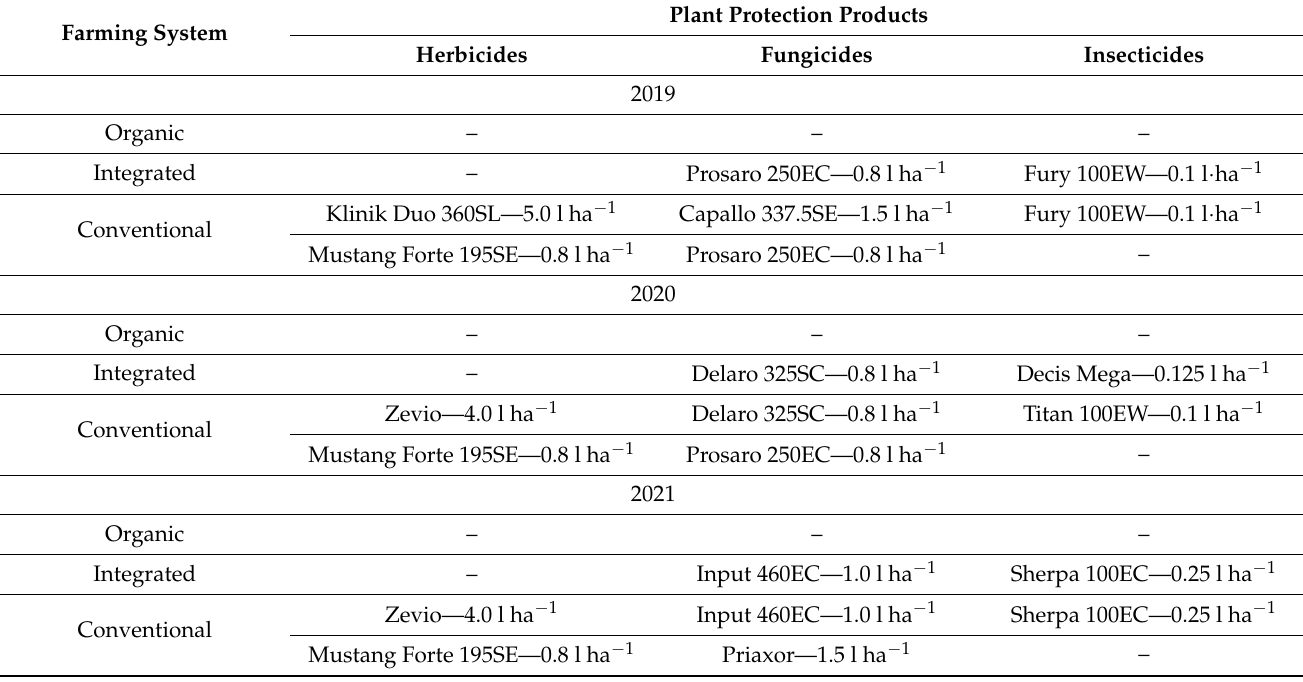
Table A1. Plant protection products used in spring wheat cultivated in different farming